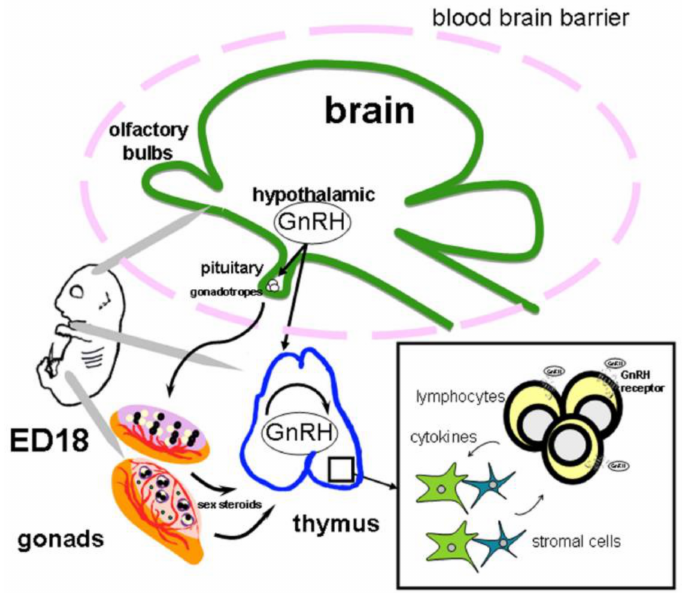
Figure 3. Model of the gonadotropin-releasing hormone (GnRH) regulation in the thymus during ontogeny. During prenatal development, before the establishment of the hypothalamic-pituitary- gonadal regulation in rodents, hypothalamic GnRH is found in the general blood circulation in high concentrations and can provide a direct effect on the morphogenesis of thymus via specific receptor in thymocytes. In addition, the effect of GnRH synthesized in thymus can be realized by autocrine or paracrine regulation. During early development, the effect of GnRH is mediated by cytokines whose synthesis in the thymus is upregulated by this neuropeptide. During the postnatal period, GnRH is involved in the bidirectional programming of the both neuroendocrine and immune functions via gonadotropins and sex steroids. Sex steroids modulate the GnRH level in the thymus. Abbreviation: ED—embryonic